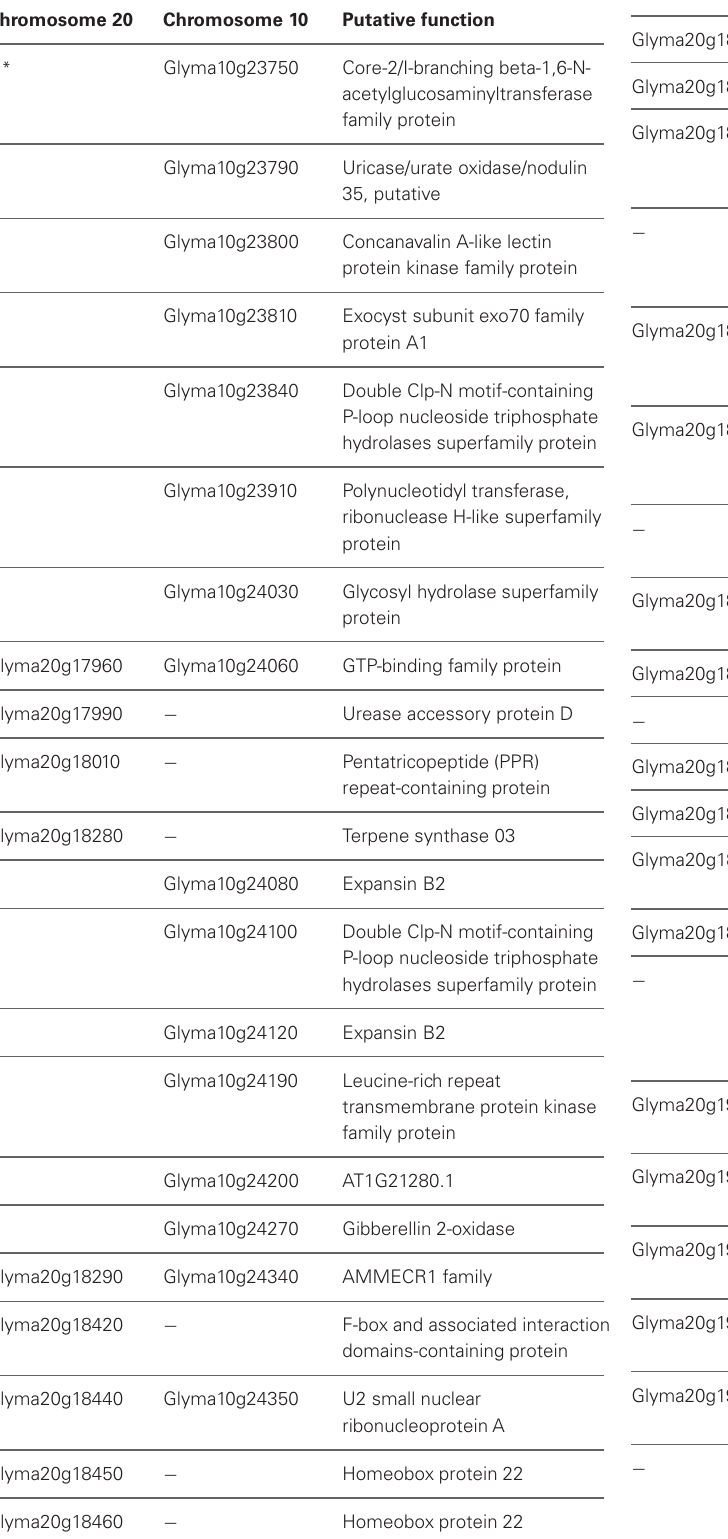
Table 1 | Gene divergence of duplicated regions between Chr